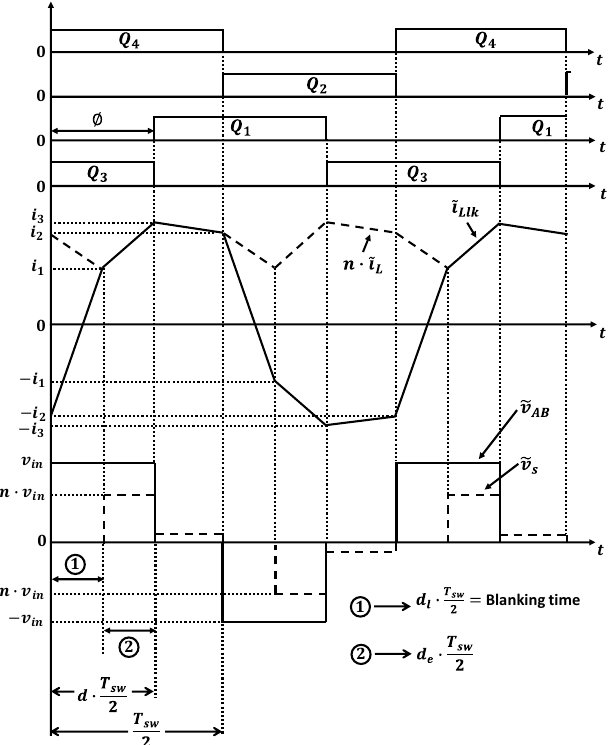
Figure 2. PSFB steady-state waveforms (the blanking time interval has been exaggerated to highlight the effect).